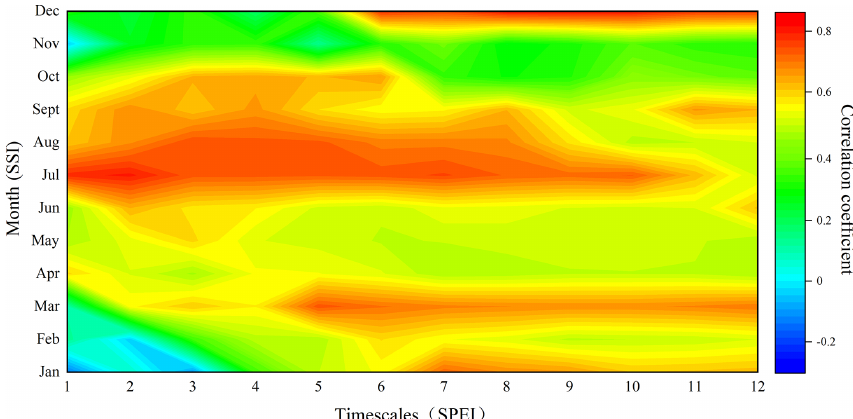
Figure 4. The correlation coefficients between monthly SSI and SPEI with different timescales at subbasin no. 6.